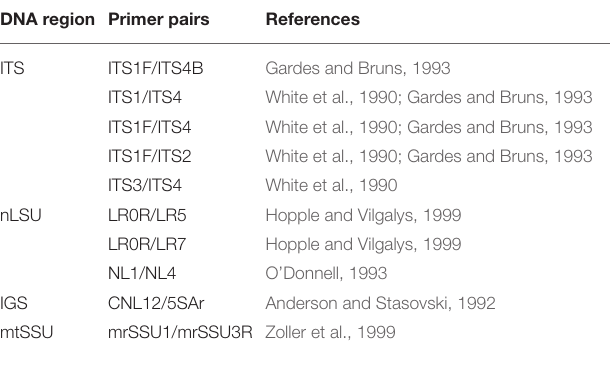
TABLE 1 | List of primers used for PCR and sequencing in this study. DNA region Primer pairs